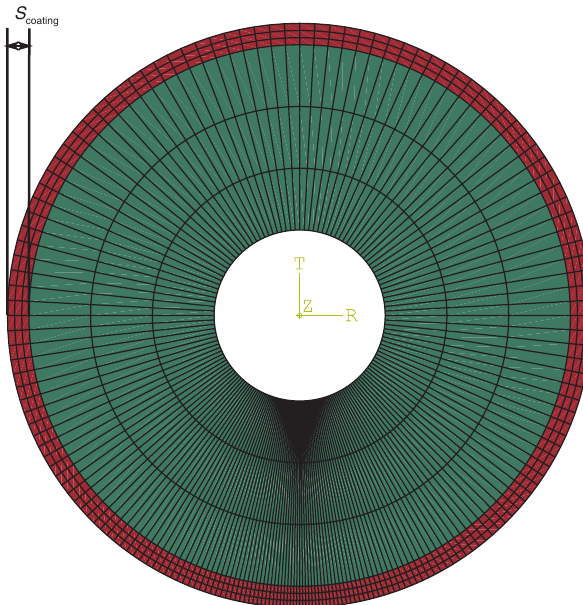
Figure 8 Simplified model of the compaction roller for the FEM simulation. static test was performed, and then the pressure-sensitive film was scanned and smoothed. On the reflections, the undulated imperfections of the roller are visible, which also correspond to the pressure results. The surface rough- ness of the tools of Rz < 0.7 was well below the required surface roughness of Rz = 6.3 of the pressure-sensitive film.